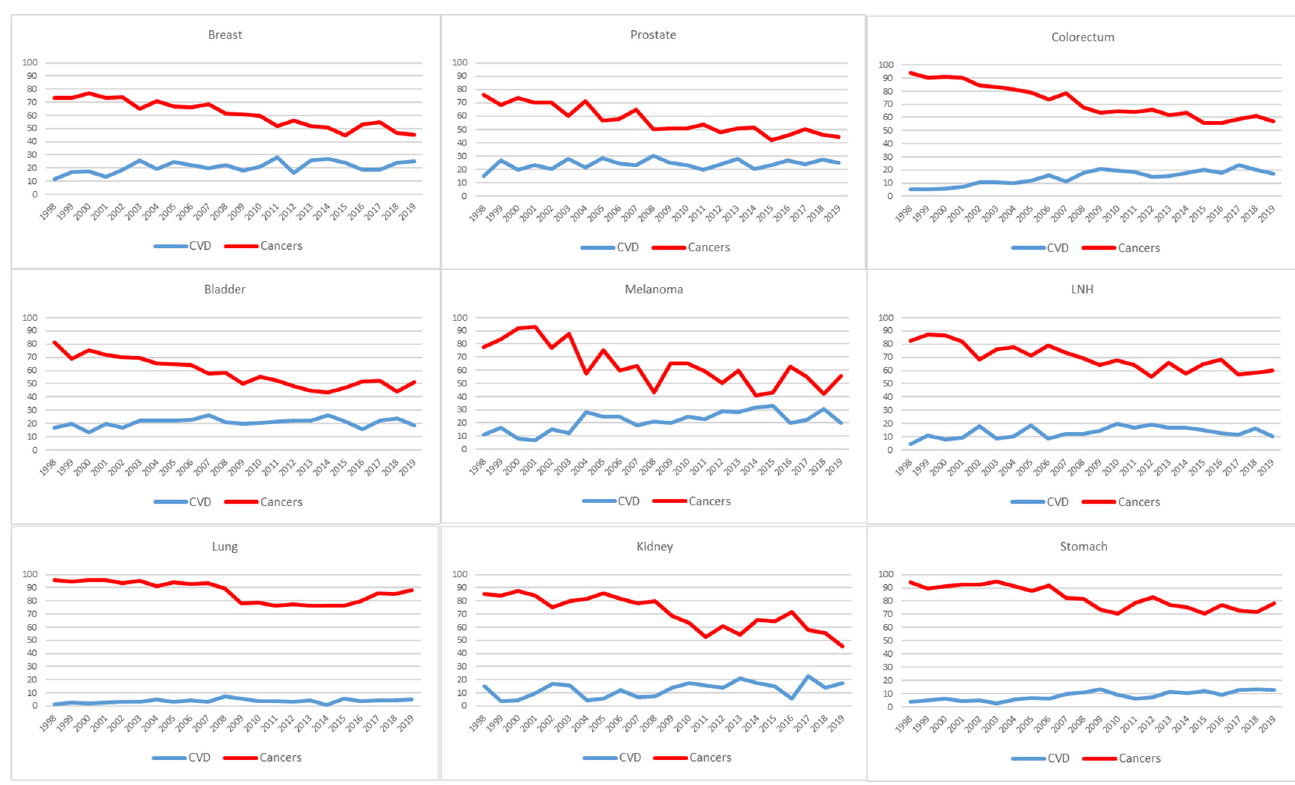
Figure 3. Percentage analysis of cause of death in cancer survivors by cancer site and year of death, Reggio Emilia, Italy, 1996–2019. Percentages were calculated on deaths that had occurred in the year among can-cer patients diagnosed from 1996, i.e., deaths in 1996 only include fatalities that oc-curred in patients diagnosed in 1996, while deaths that occurred in 2019 include fatali-ties in cancer survivors diagnosed from 1996 to 2019.